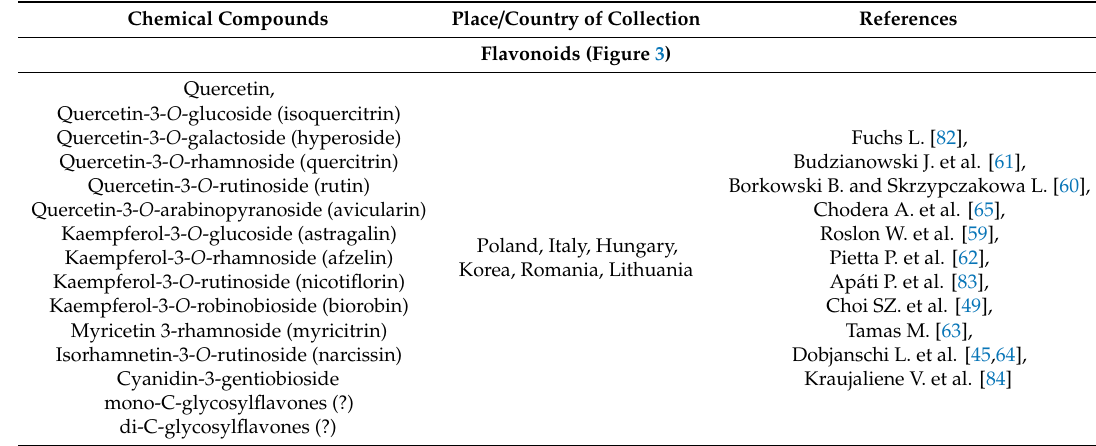
Table 1. Chemical compounds identified in S.